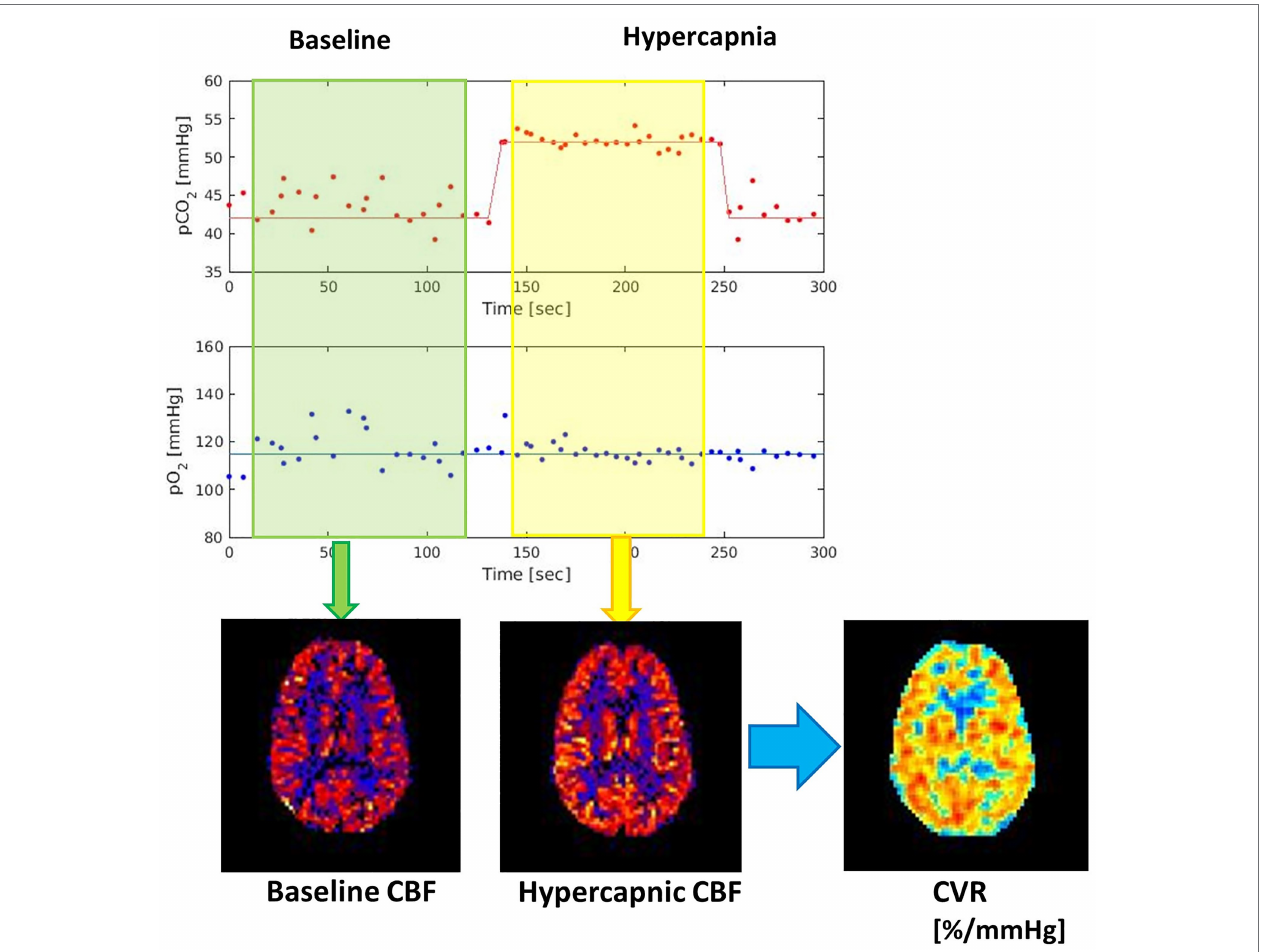
FIGURE 1 | Vascular reactivity measurement using a hypercapnia paradigm. Per-voxel based cerebrovascular reactivity (CVR) images are generated by calculating % changes of blood flow per mmHg of partial pressure of CO 2 (PCO 2 ).